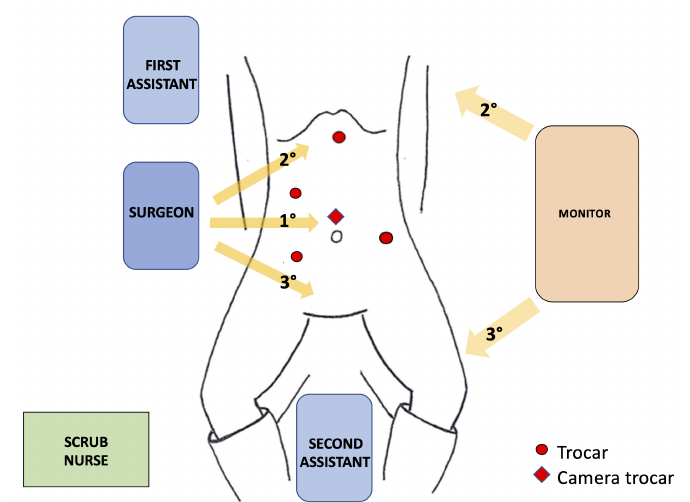
Figure 6. Operatory room setup. The patient is positioned on stirrups. Yellow arrows indicate the visual line of the surgeon during the three parts of the laparoscopic steps of the procedure with the consensual adjustment of the monitor.